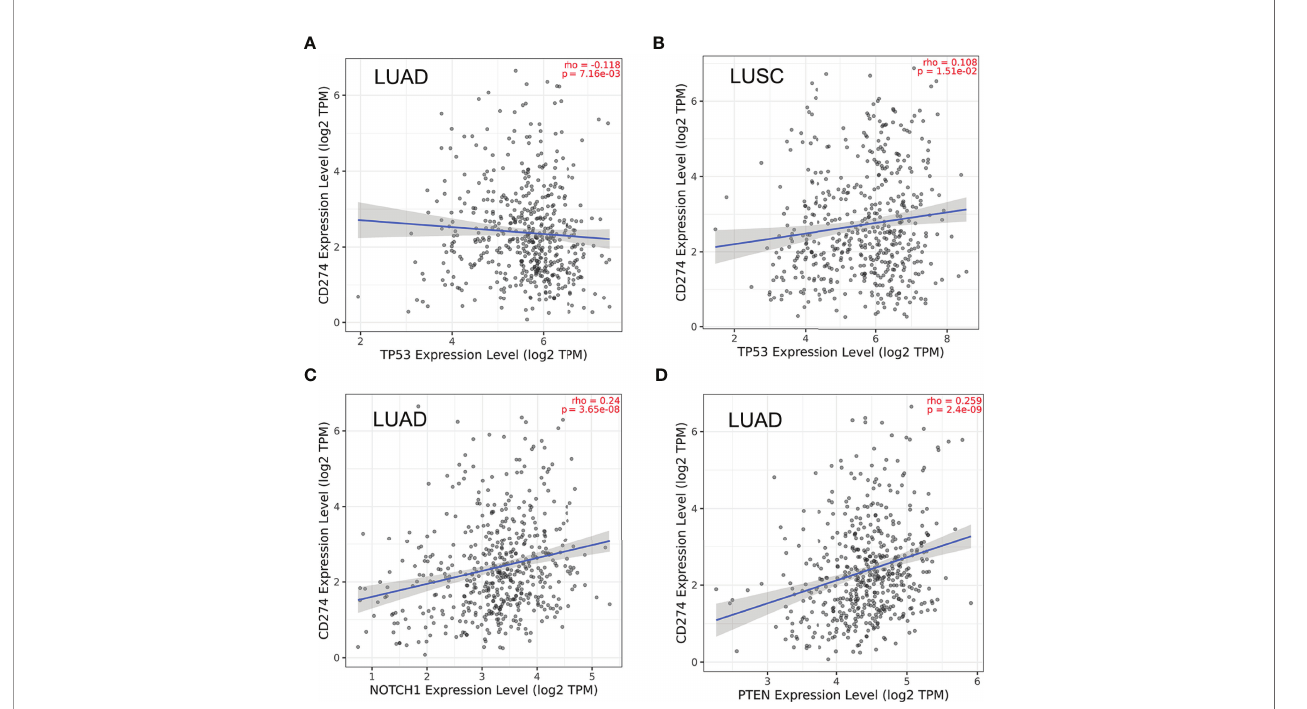
FIGURE 5 | Correlations between PD-L1 (CD274) and the 5 core target genes were evaluated using TIMER 2.0 database. (A) TP53-PD-L1 in LUAD. (B) TP53-PD- L1 in LUSC. (C) NOTCH1-PD-L1 in LUAD. (D) PTEN-PD-L1 in LUAD.